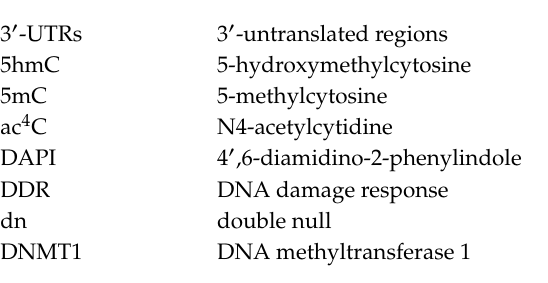
Figure S1: The levels of proteins regulating m 6 A RNA and DNA damage response. Panels are showing the quantification of Western blot data from Figure 6e,f; Figure S2: The levels of NOCL1 (red) and SMD1 (red) factors were not changed when m 3 G / TMG was reduced by local laser microirradiation. a, The NOLC1 protein was not recruited to DNA lesions. b, the level of the SMD1 protein was identical before and after local laser microirradiation. Author Contributions: A.S.K. was responsible for Western blotting, immunofluorescence, confocal microscopy, and local microirradiation using the UVA laser (355-nm, 405-nm); A.S.K. analyzed the fluorescence intensity in the micrographs and the densities in the Western blot images; E.B. coordinated the experimental e ff orts, suggested a majority of the experiments, finalized all images, and wrote the paper. A.K. was responsible for acquiring the sequencing data and related analyses; D.K. conducted the irradiation of the whole cell populations; S.L. was responsible for STED measurement and analysis, and L.S. analyzed the METTL3, METTL14, METTL16 methyltransferases, and the FTO demethylase at locally microirradiated chromatin; P.F. performed data quantification and related analyses by confocal microscopy. All authors have read and agreed to the published version of the